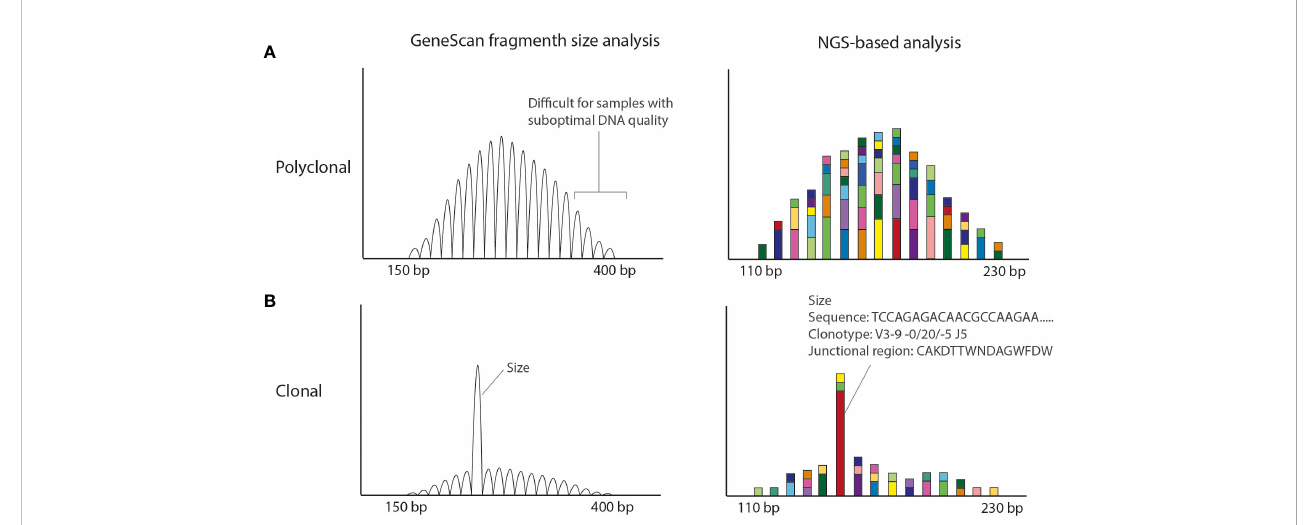
FIGURE 1 Conventional EuroClonality/BIOMED-2 fragment size vs NGS-amplicon based clonality analysis. (A) Polyclonal pattern observed in Genescan and NGS- based analysis. The size of the amplicons is smaller in the NGS-based approach making the technique more suitable for smaller DNA fragments obtained from FFPE material. (B) Clonal result (with low polyclonal background). Using GeneScan analysis only the size of the rearrangement is known, whereas with NGS-amplicon based clonality also the nucleotide sequence is obtained. The Bioinformatic program ARResT/Interrogate processes the nucleotide sequences into clonotypes, in which the used V, D and J genes as well as the junctional region in amino acids are de fi